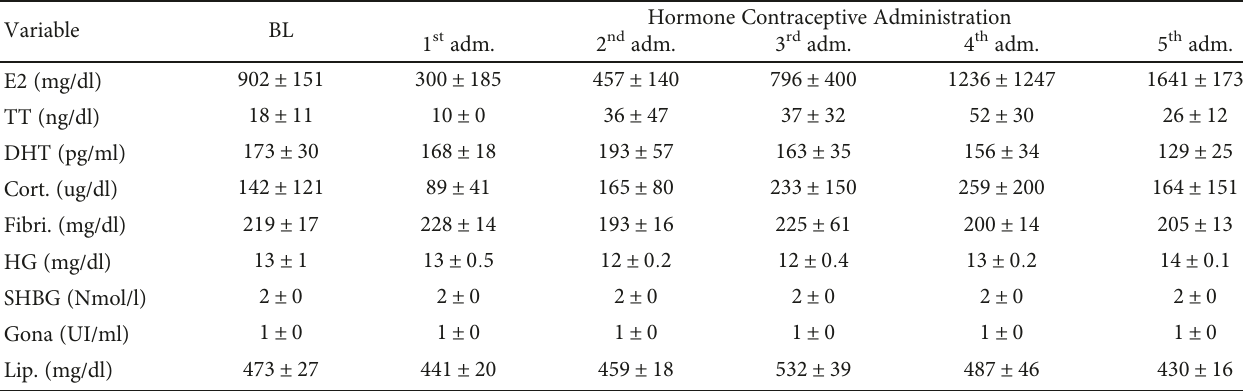
Table 1: Mean ± SD of physiological variables measured during the BL (baseline) and CHC (combined hormonal contraceptive) phases in six female capuchin monkeys. Variable